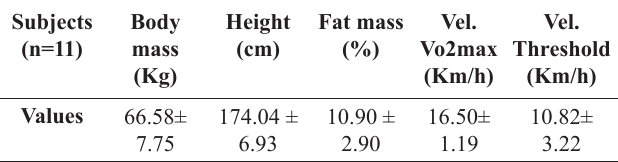
Table 1. Characterization of the